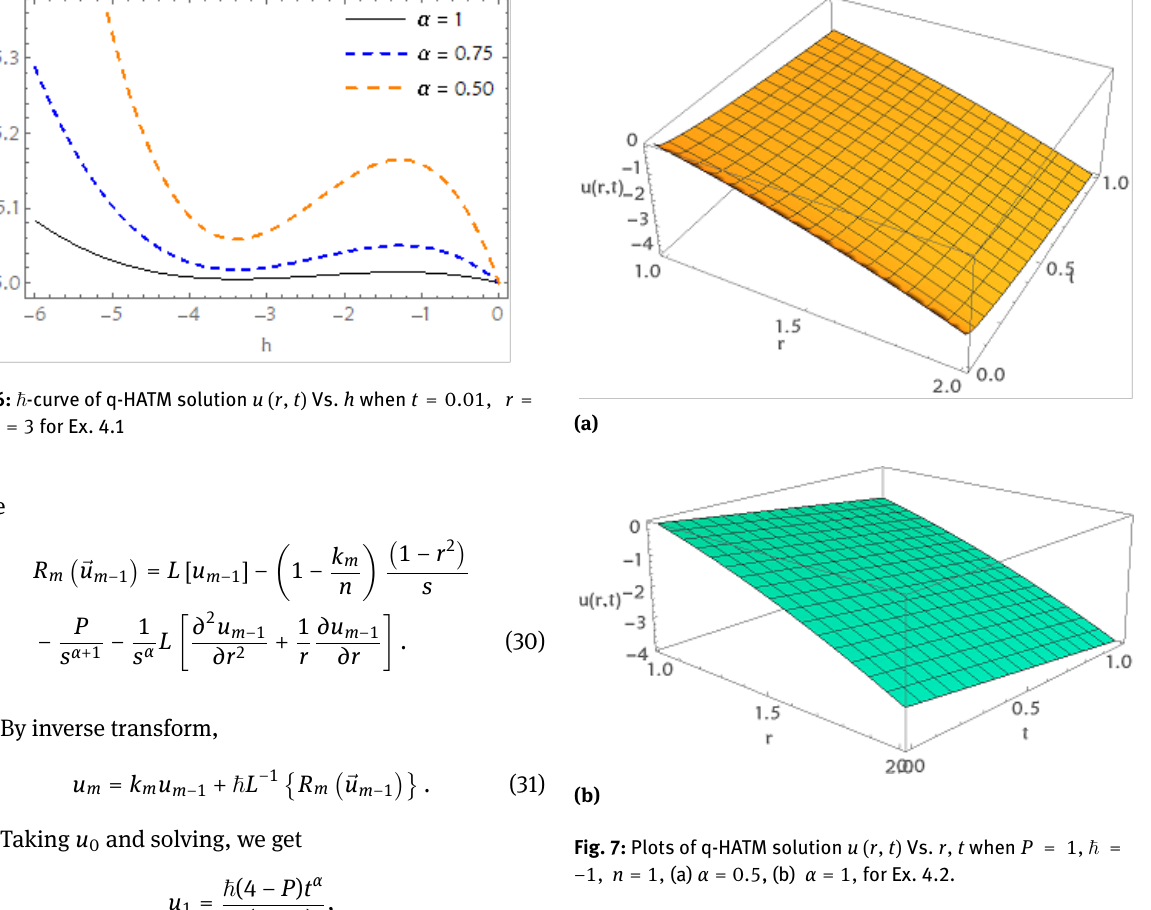
α and standard case α = 1 at r = 1.5, (cid:126) = −1, n = 1 =